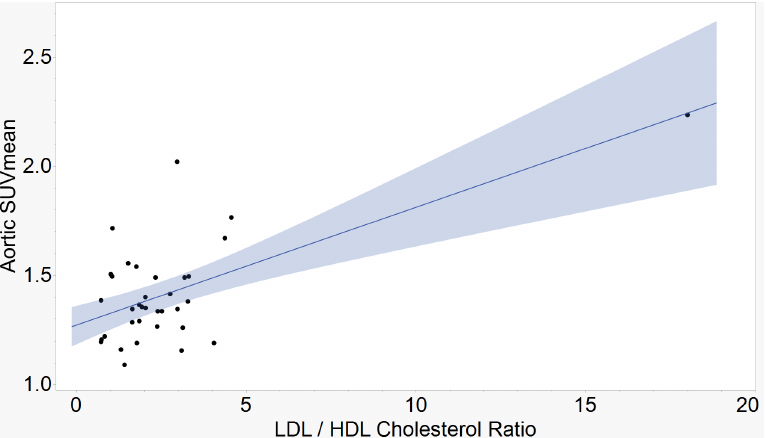
Figure 2. Aortic SUVmean vs. Castelli’s Risk Index II (CRI-II). The ratio between low-density lipoprotein and high-density lipoprotein cholesterol demonstrates a strong, positive correlation with mean tracer uptake in the aorta. (r = 0.64, p < 0.0001, n = 35).